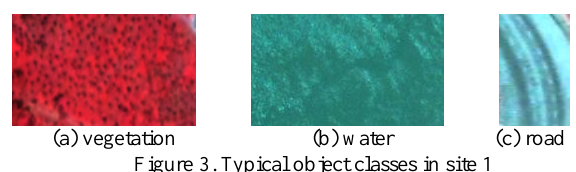
Figure 3. Typical object classes in site 1 From figure 4, we know different object classes correspond to different semivariograms, and thus they have different spatial variabilities. Semivariograms of water and vegetation are quite simple and similar except in band 4, and their ranges are all about between 2~4 pixels by visual inspection. Comparing with water and vegetation, semivariogram of the road is relatively complex, which is continuously fluctuant and unstable when lag h exceeds the range, implying that roads have more complex variation structure. The range of its semivariogram is about between 8~9 pixels. The detailed range information of the three object classes in site 1 is listed in table 1.